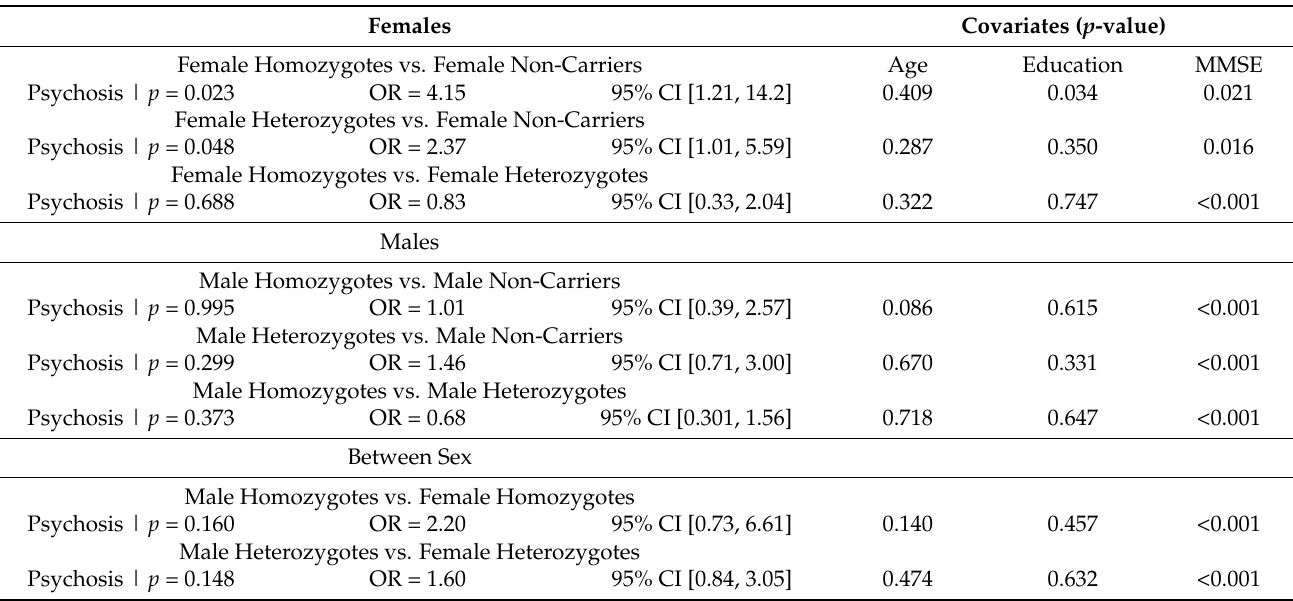
Table 2. LB (+) Cohort, GAM.